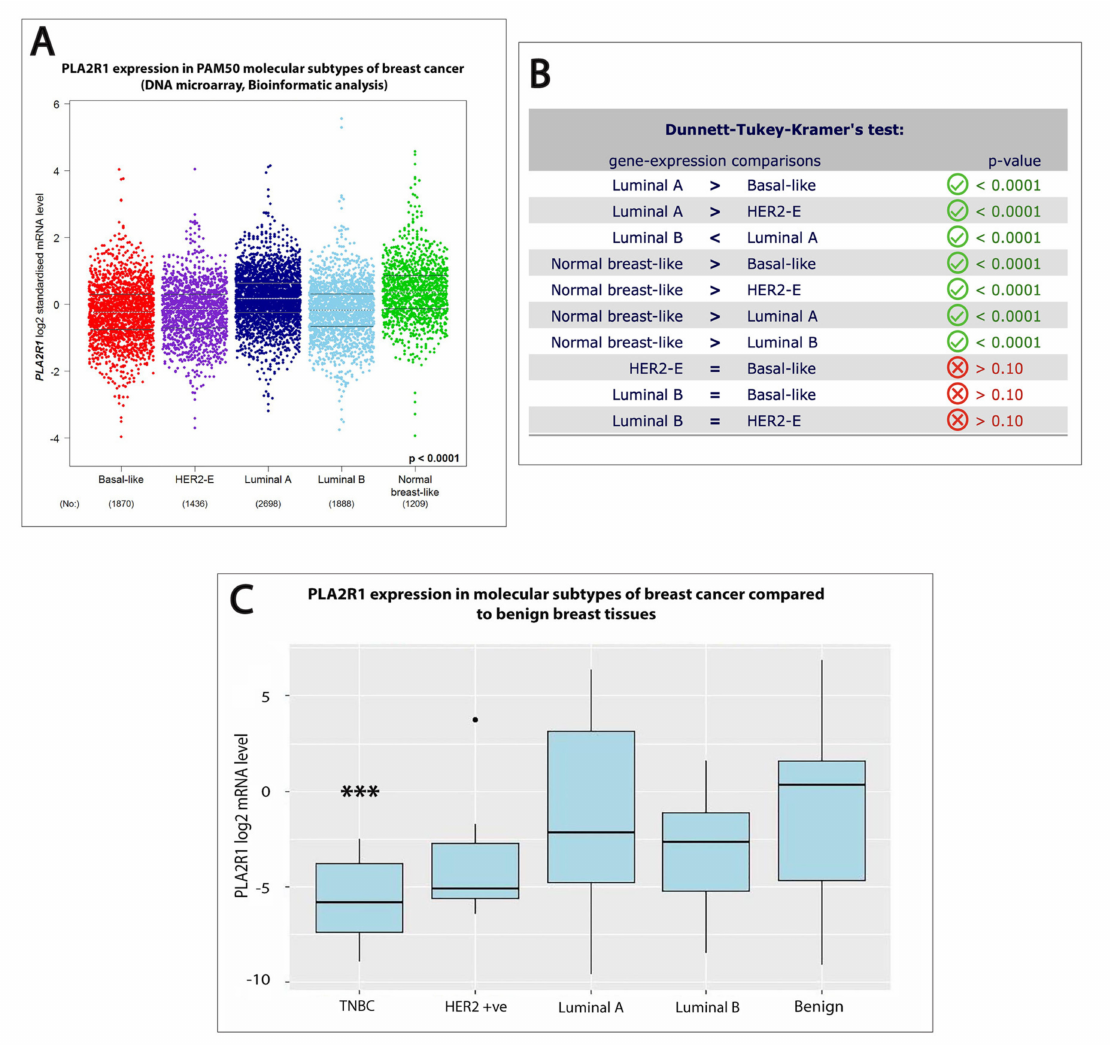
Figure 2. Lower level of PLA2R1 mRNA expression was significantly associated with Triple Negative Breast Cancers (TNBC). ( A ) Boxplots displaying lower expressions of PLA2R1 mRNA levels in basal-like, luminal B and HER2-positive breast cancers compared to luminal A and normal breast-like cancers ( p < 0.0001) based on the bioinformatics analysis from the bc-GenExMiner DNA microarray database. ( B ) p values generated by Dunnett–Tukey–Kramer’s test to evaluate the difference in gene expressions amongdistinctmolecularsubtypesretrievedfrombc-GenExMinerDNAmicroarraydatabase. ( C )Boxplots demonstrating lower expression levels of PLA2R1 mRNA in different molecular subtypes of breast